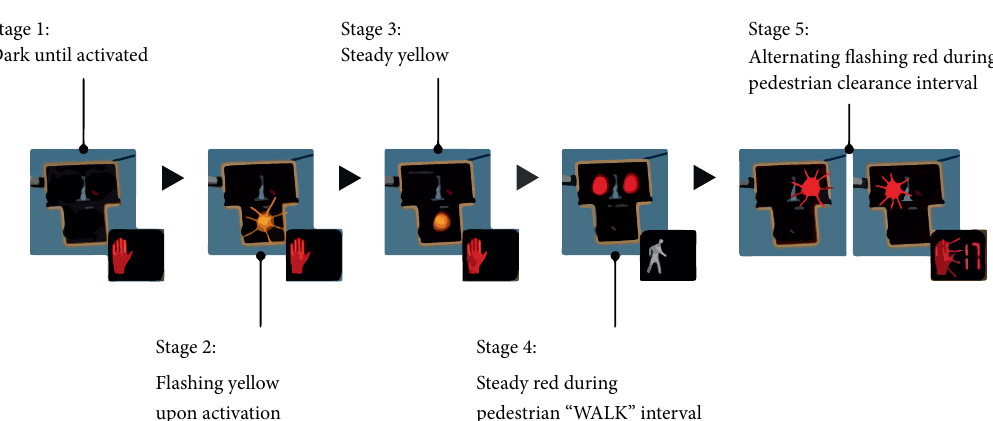
Figure 1: The operation of pedestrian hybrid beacon